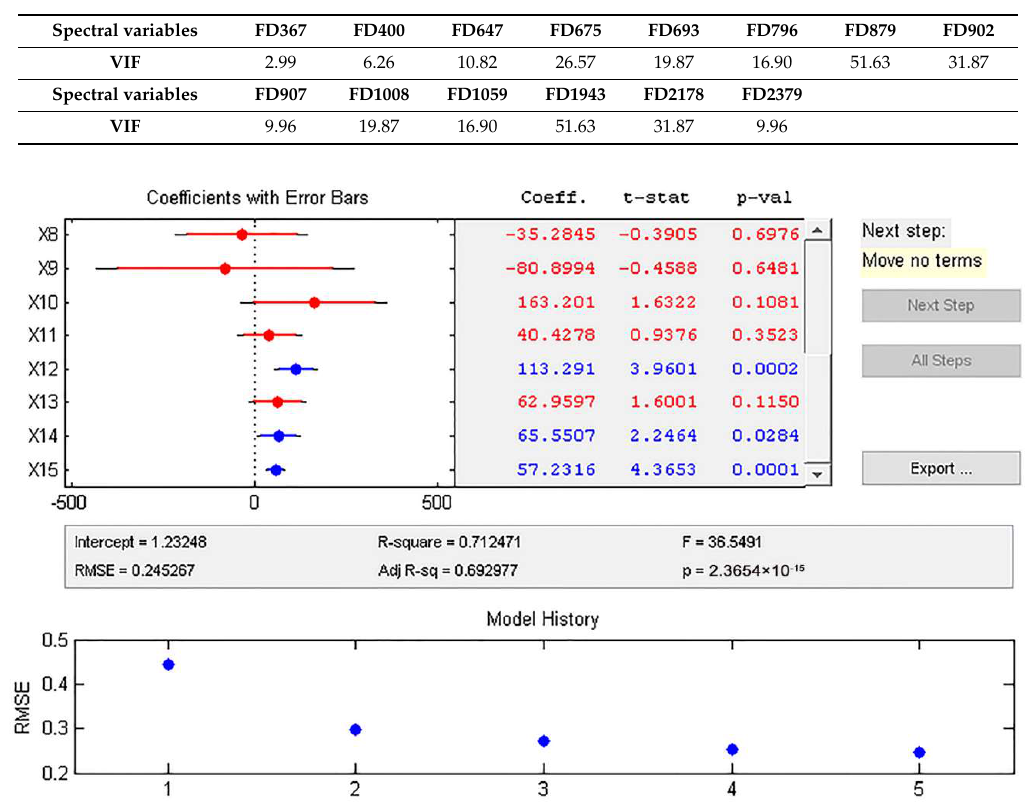
Table 6. The variance inflation factor (VIF) values of 15 spectral variables selected by the Boruta algorithm for estimating the content of soil heavy metal Cd.